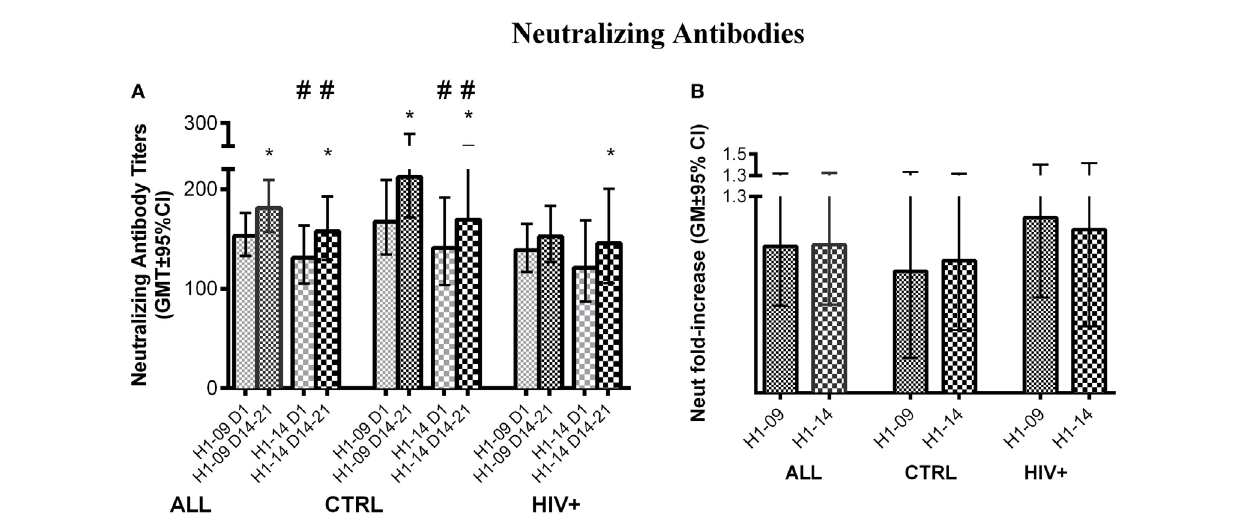
FigUre 4 | neutralizing antibody responses to laiV4 . The data were derived from 45 HIV-infected and 55 uninfected individuals. (a) Absolute responses in each group of participants, as indicated below the abscissa, at V1 (before vaccination) and V4 (14–21 days after vaccination) and against the viruses indicated in the labels of the abscissa. Asterisks (*) indicate significant differences between pre- and post-vaccination. Hash tags (#) indicate significant differences ( p < 0.05) and strong trends (0.05 ≤ p < 0.1) between H1N1-09 and H1N1-14. (B) Fold-increases from pre- to post-vaccination.